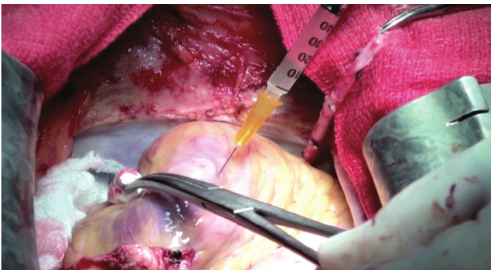
Figure 1: Picture showing the intraoperative injection of the CD133 + stem cells into the infarcted area and infarct border